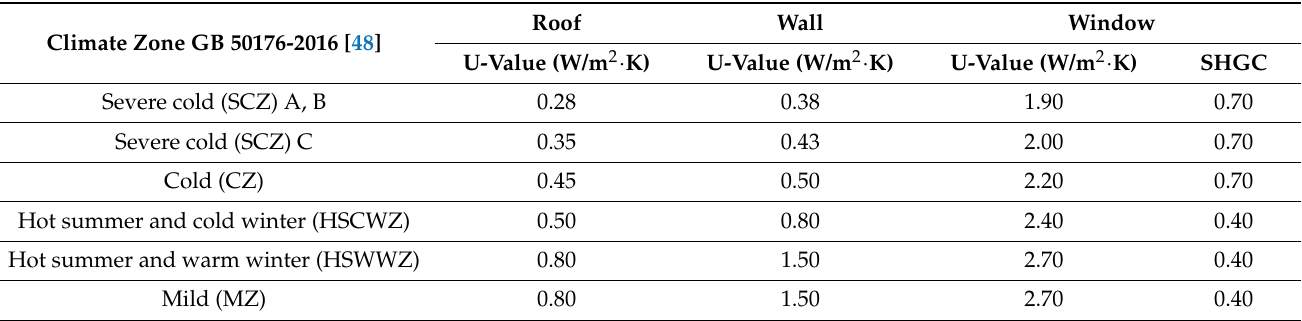
Table 4. Summary of the BEM simulated envelope characteristics according to GB 50176-2016 climate zones specifications, following Bai and Wang’s [60] (p. 713, Table 2) assessment.